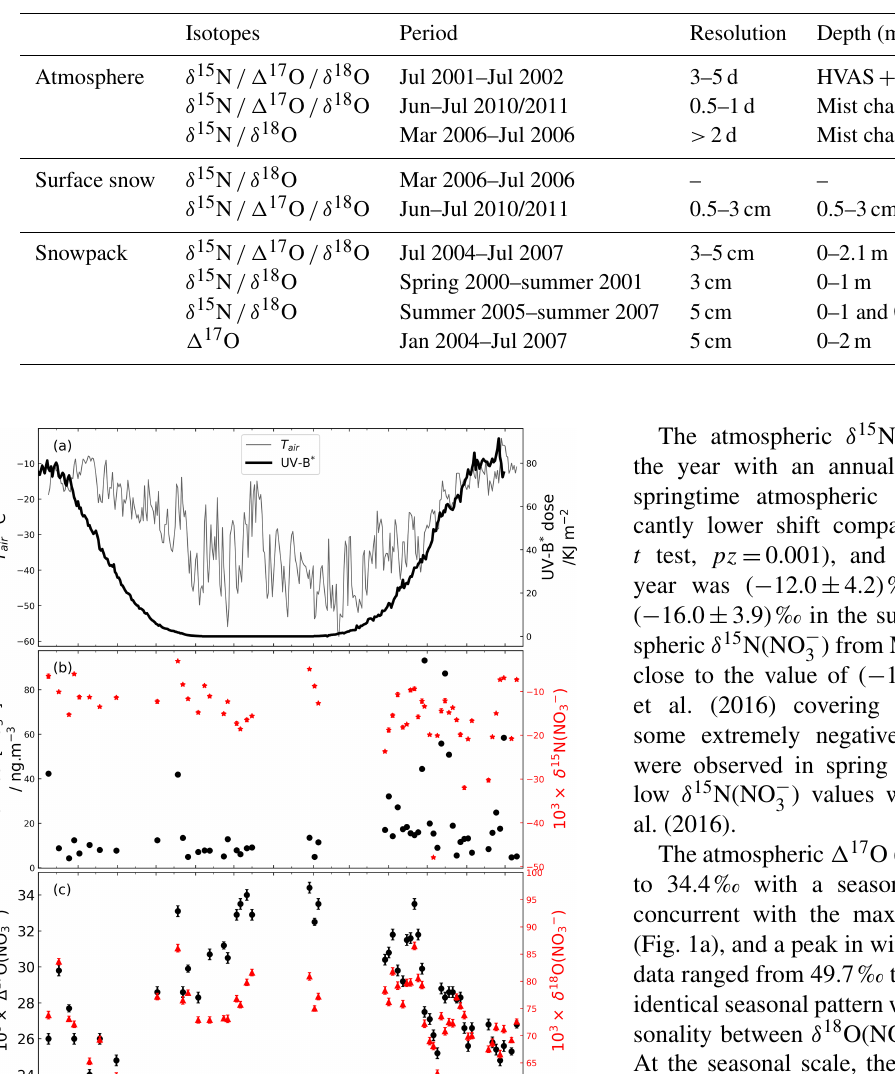
Table 1. Nitrate isotope data information and references. The atmospheric sampling technique in different studies is also listed in the table.